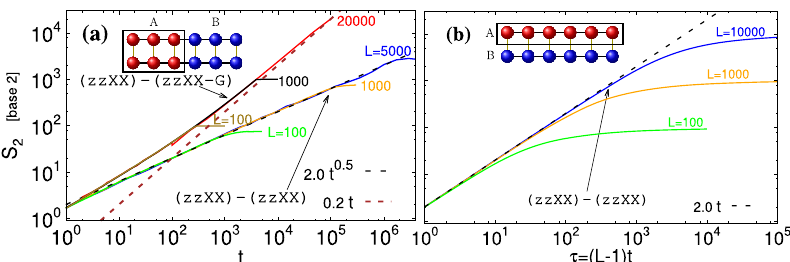
Fig. 1 Ballistic growth of S 2 in systems with single diffusive degree of freedom (DOF). a Floquet ladder model with a single diffusive DOF (zzXX-(zzXX-G)) vs. diffusive growth for two diffusive DOF (zzXX-zzXX). b Even if spin on both legs is diffusive one can get the ballistic growth for the shown bipartition to A and B. Blue and red balls sketch spins in ladders and subsystems A and B. The initial state is ð 0 j i þ 1 j iÞ (cid:4) 2 L and different colored curves denote different system sizes L